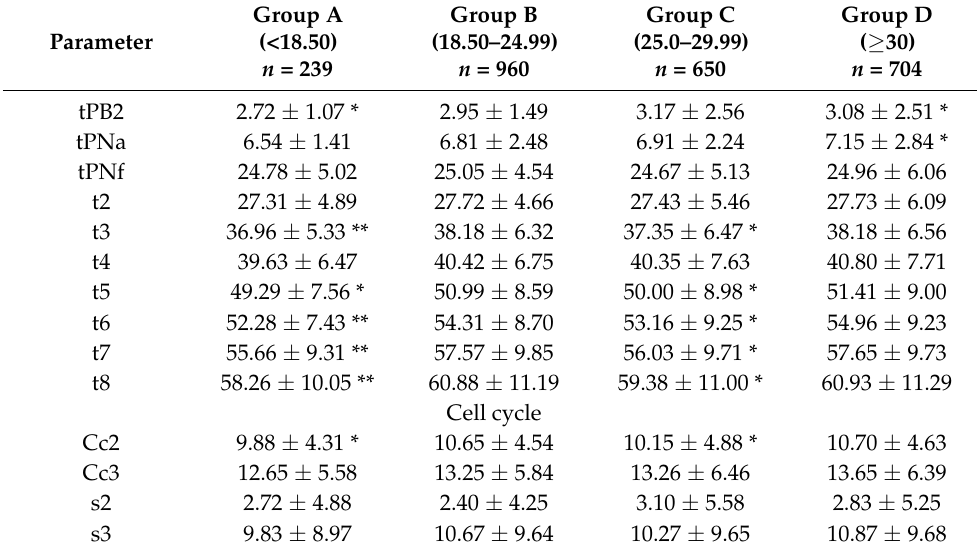
Table 3. Morphokinetic parameters (hours) of all available embryos according to BMI group.